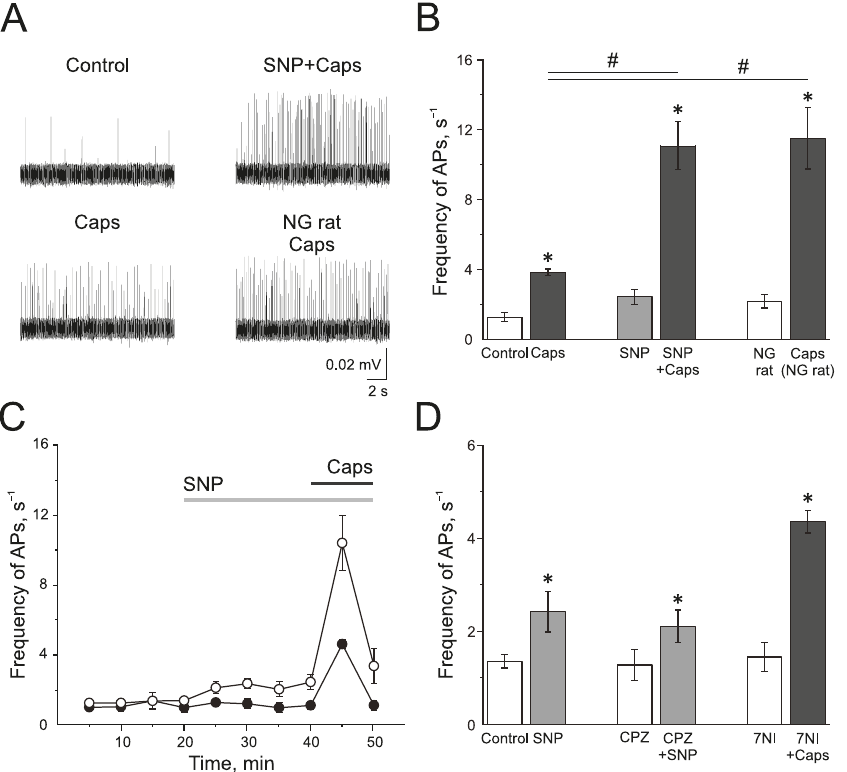
Figure 5. Effects of NO on activity of TRPV1 in the rat trigeminal afferents. ( A ) Sample traces of AP in the trigeminal nerve in controls, after the application of capsaicin (1 µ M), capsaicin in the presence of NO donor, SNP (200 µ M), and the application of capsaicin in NG-induced migraine model group. ( B ) Histogram showing the mean frequency of AP per 5 min in the trigeminal nerve after the application of capsaicin in the control, after application of the NO donor SNP and in the NG-induced migraine model group; ( C ) The time-course of frequency of AP after the application of capsaicin in the control (black circles) and after the application of SNP (white circles); ( D ) Histogram showing the mean frequency of AP per 5 min after the application of SNP in the control group, application of SNP after the inhibition of TRPV1 receptors by capsazepine (20 µ M) and capsaicin after inhibition of nNOS by 7NI (1 mM). Mean ± SEM. * p < 0.05 (compared to the control); # p < 0.05 (compared to the effect of capsaicin in the